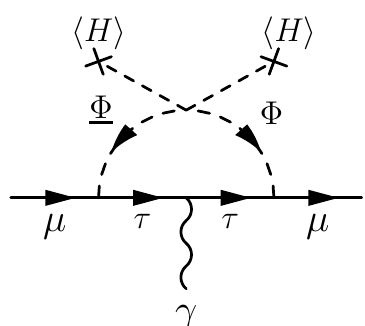
Figure 1 . Feynman diagram inducing muon anomalous magnetic moment in U(1) L Z n ( n = 2 ; 3 ; ) models. (cid:1) (cid:1) (cid:1) global U(1) L symmetry is recovered in the Yukawa interactions taking into (cid:22) (cid:0) L (cid:28)